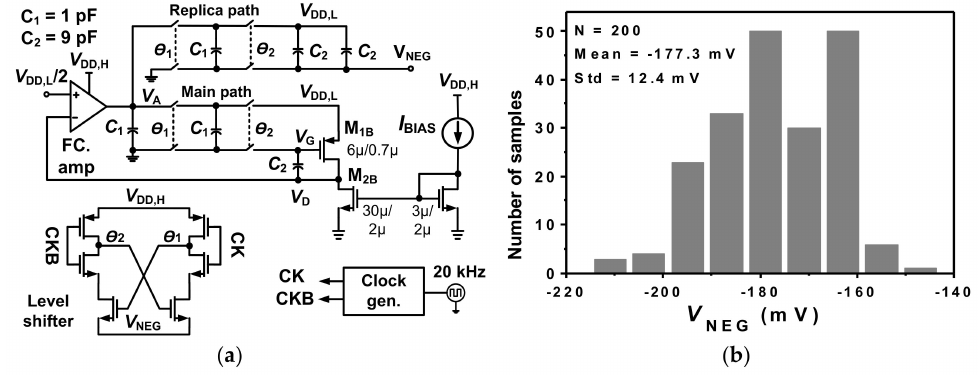
Figure 4. ( a ) Schematic of the negative voltage generator, ( b ) statistical distribution of V NEG